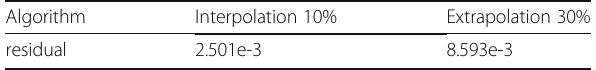
Table 2 Response residuals error of interpolation and extrapolation Algorithm